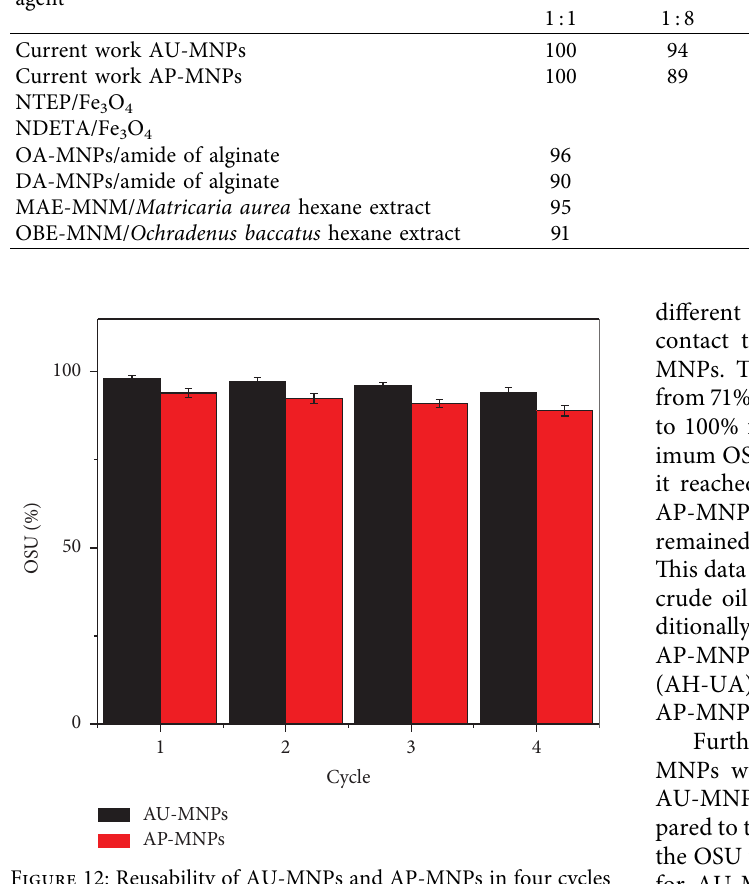
Table 1: Compression between OSUs of AU-MNPs and AP-MNPs with surface-modifed MNPs used in other studies. Abbreviation/capping